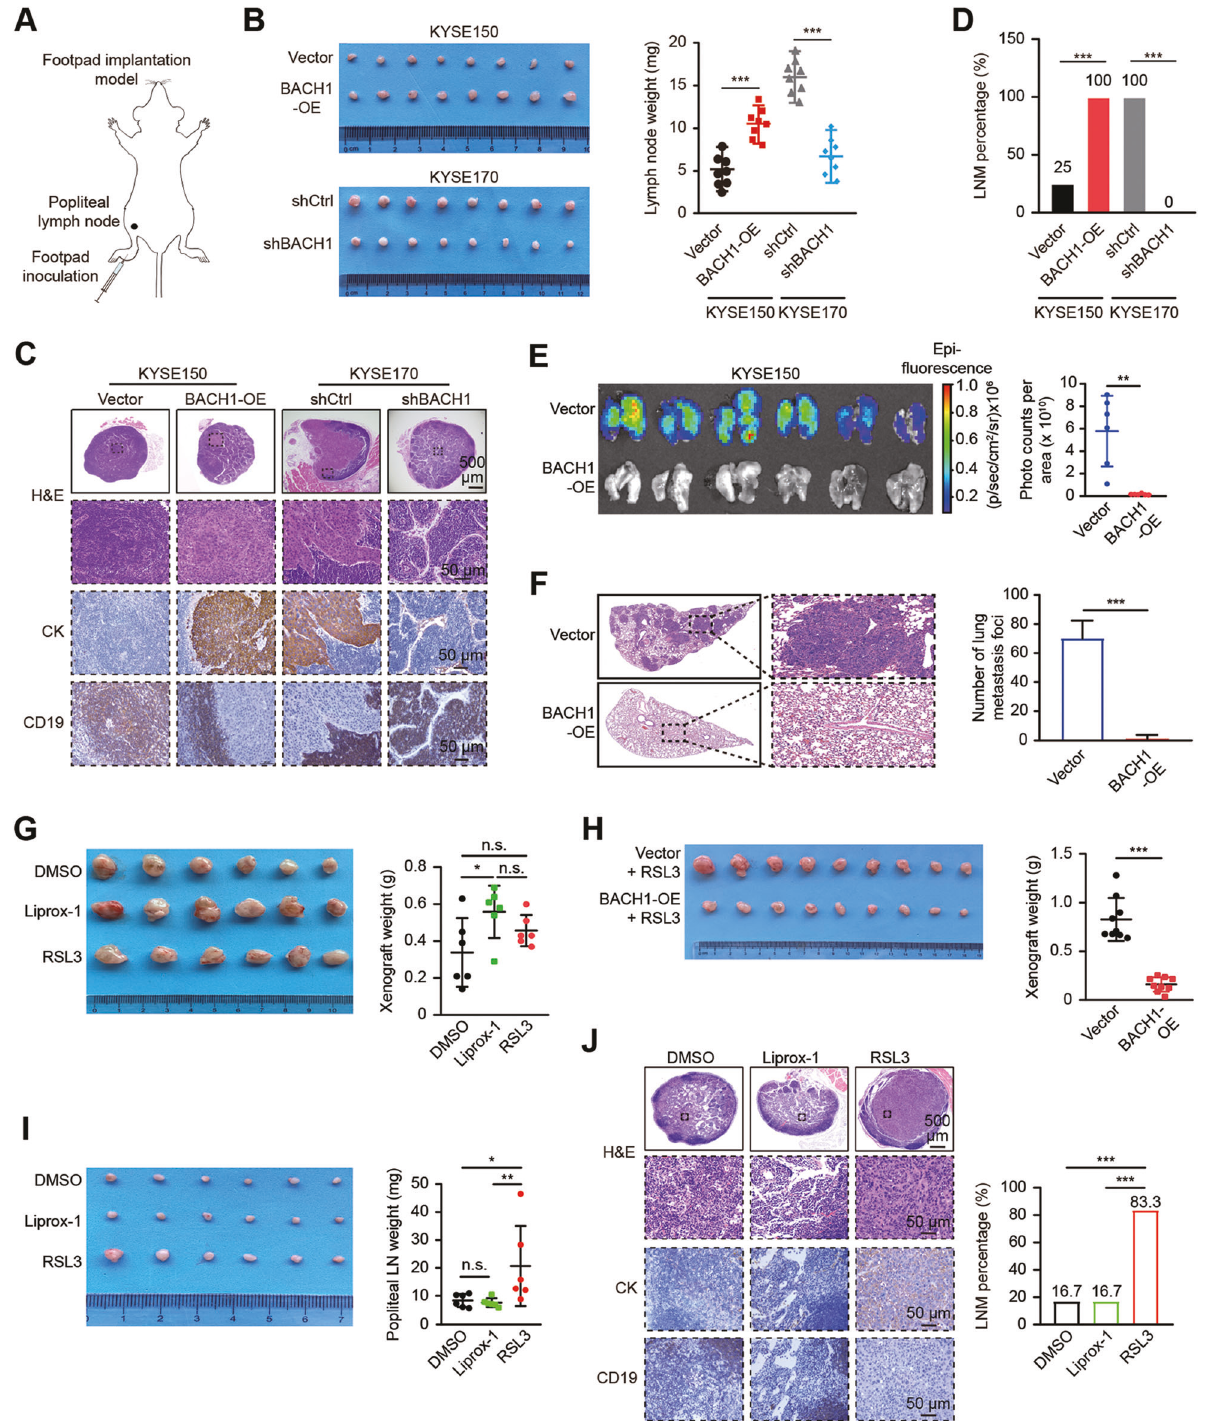
signi fi cantly changed after BACH1 overexpression (Fig.